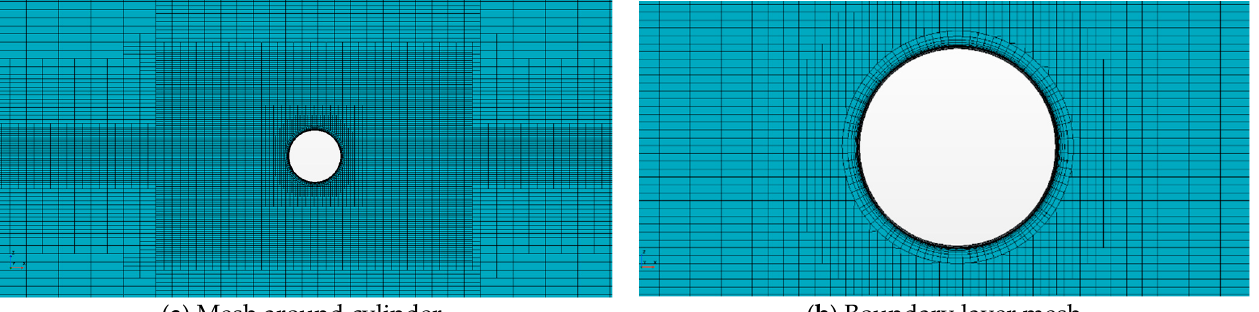
Figure 2. Mesh sketch.